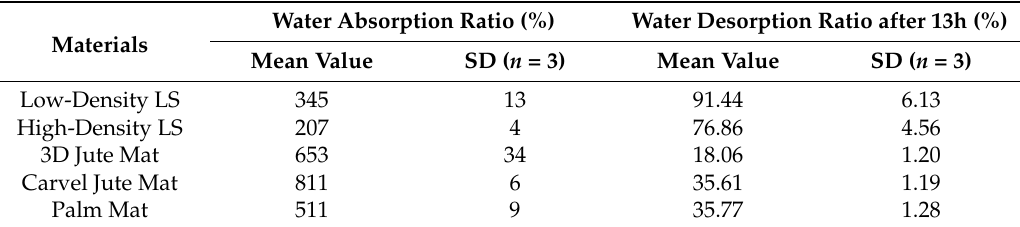
Table 4. The statistical analysis of water absorption and desorption.